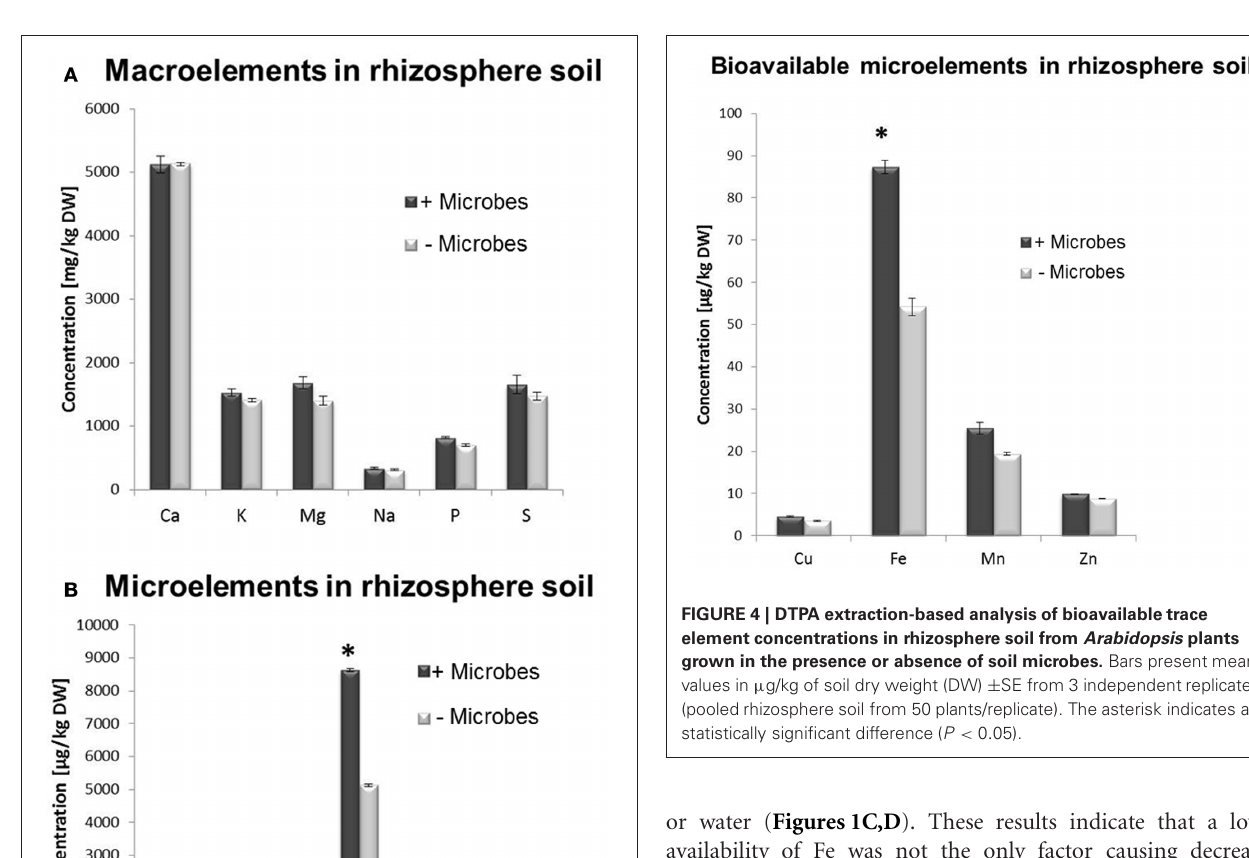
or water ( Figures 1C,D ). These results indicate that a